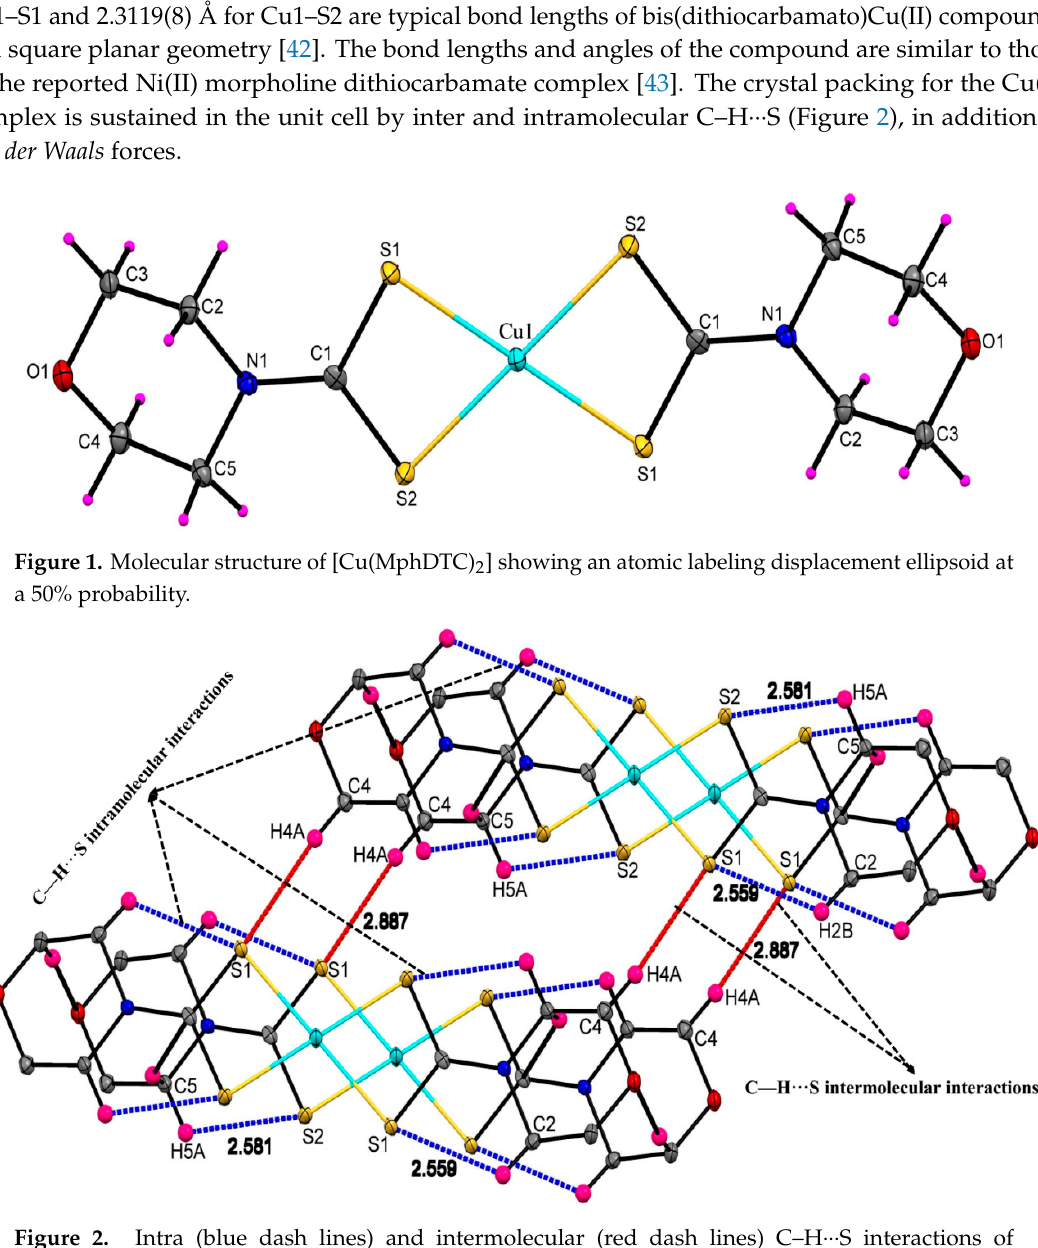
Figure 2. Intra (blue dash lines) and intermolecular (red dash lines) C–H···S interactions of [Cu(MphDTC) 2 ]. Non-interacting hydrogen atoms are omitted for clarity.